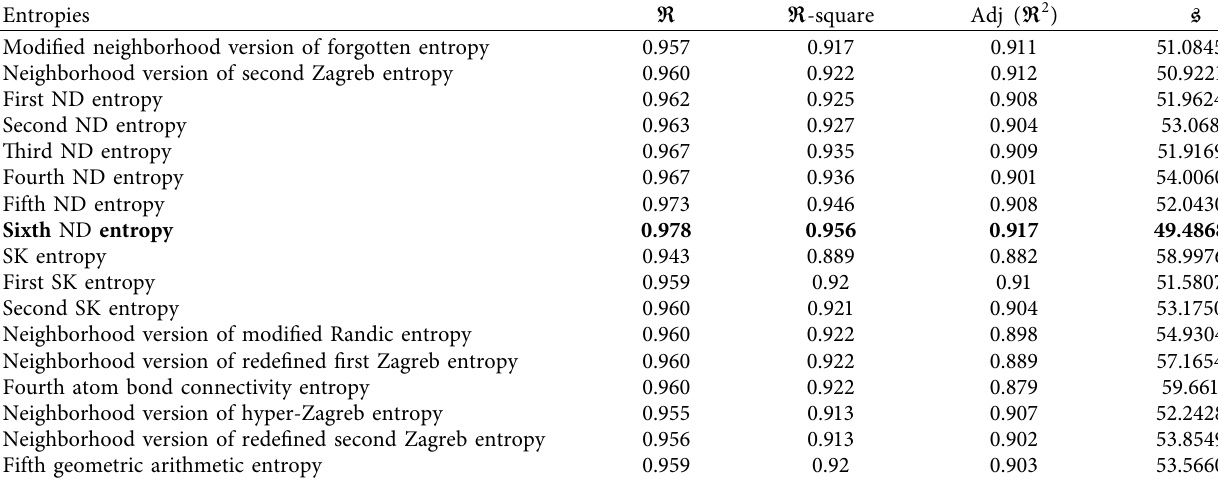
Table 7: The significant LRM: Gibb’s energy ( GE ) of benzene derivatives on